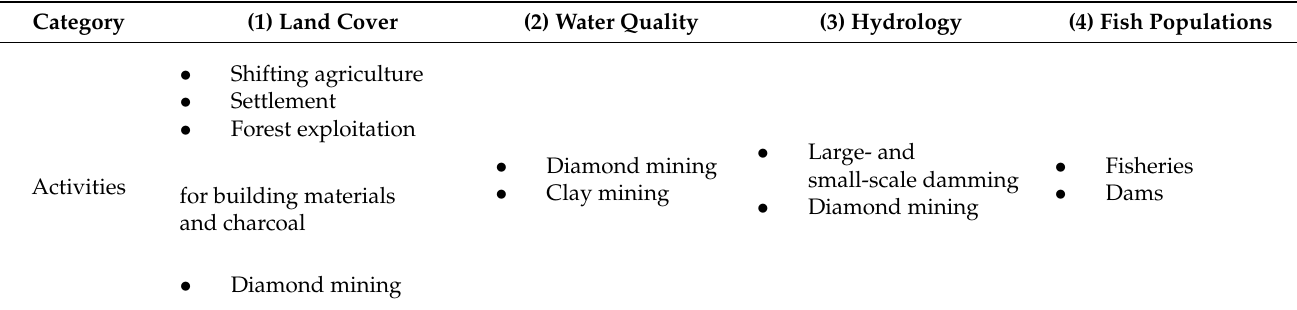
Table 1. Human activities identified in the LR valley grouped in categories following their impact on the system.